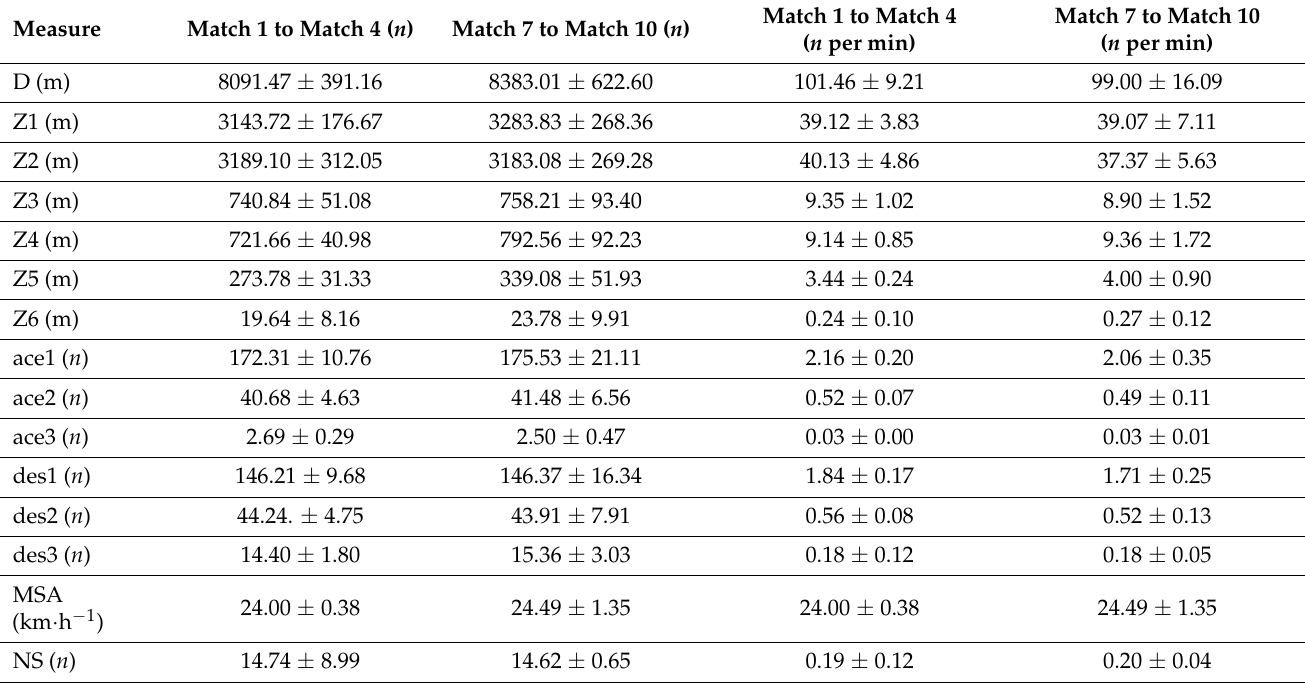
Table 2. Descriptive table of match running performance (mean ±